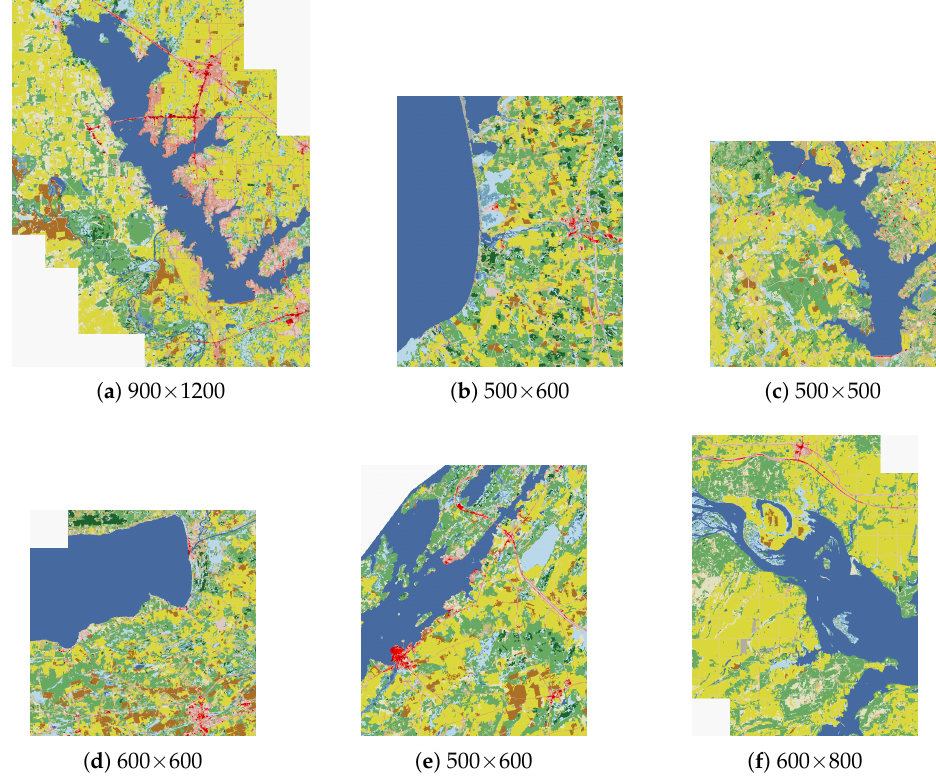
Figure 6. Top six retrieval results of reference I acquired by the use of the method proposed in